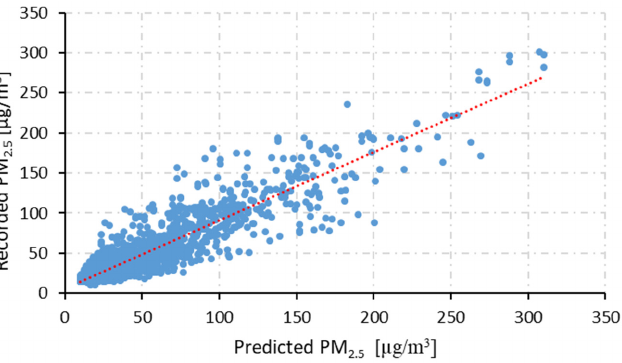
Figure 10. Scatterplot for hourly concentration of PM 2.5 recorded by the system and calculated from a model for traffic and meteorological data considered in the validation set.